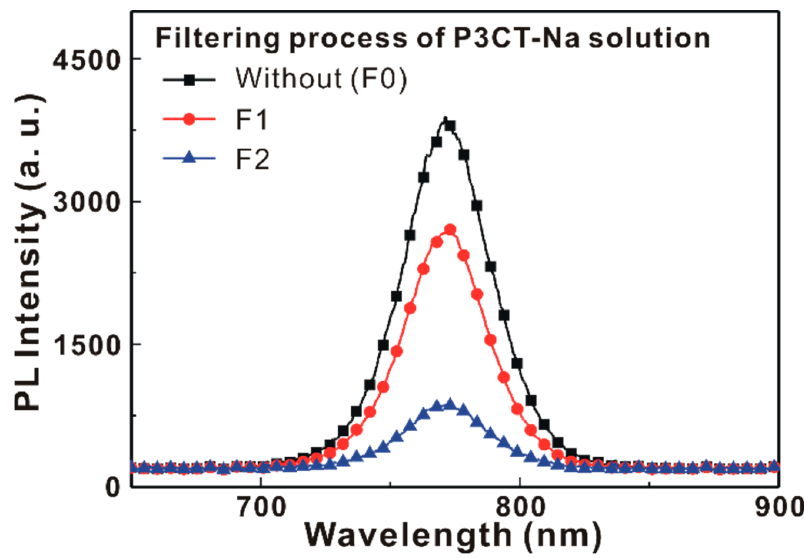
Polymers 2021 , 13 , x FOR PEER REVIEW 11 of 14 Figure 8. Photoluminescence spectra of the MAPbI 3 /P3CT-Na/ITO/glass samples. Figure 8. Photoluminescence spectra of the MAPbI 3 /P3CT-Na/ITO/glass samples.